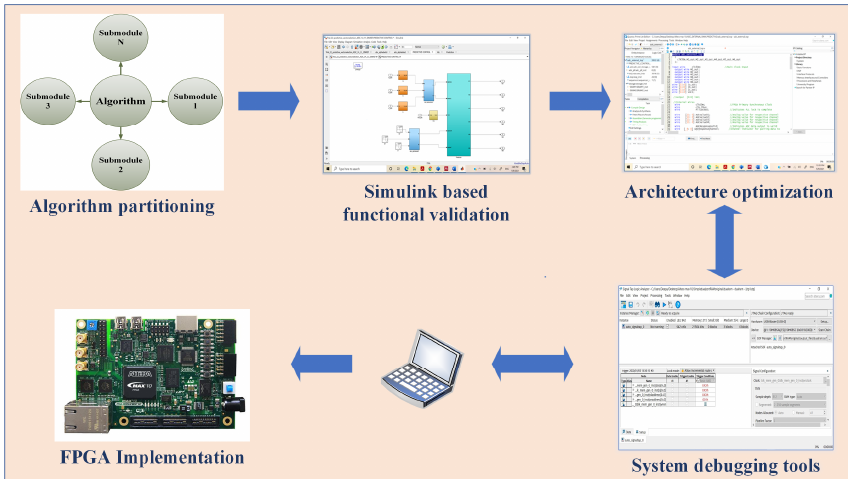
Figure 4. FDFG-based design methodology.